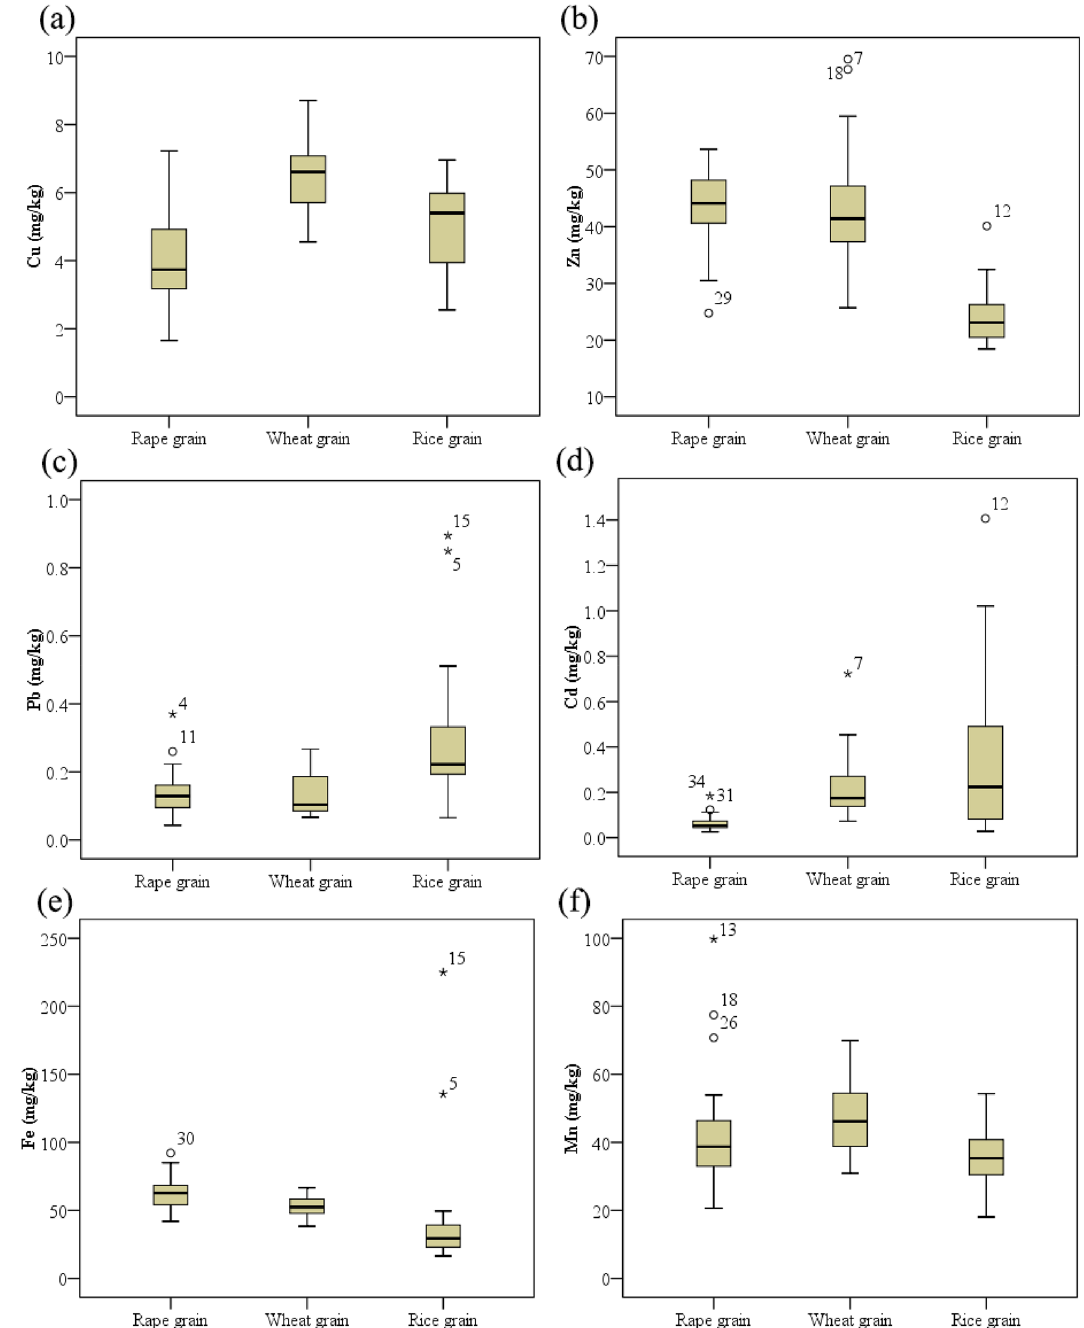
Figure 4. Concentrations of heavy metals ((a) Cu, (b) Zn, (c)Pb, (d) Cd, (e) Fe, and (f) Mn) in the grain of three different crops. (Rape grains (n = 36); Wheat grains (n = 25); Rice grains (n = 20), on dry weight